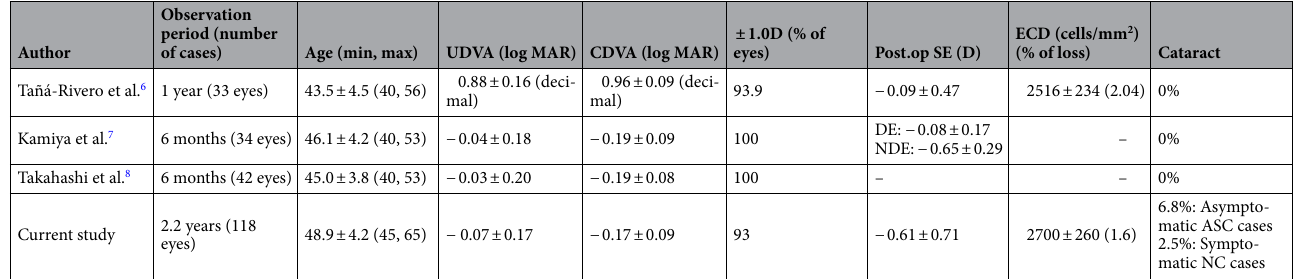
Table 5. The reports on Hole implantable collamer lens (ICL) implantation in patients over 40 years of age. UDVA uncorrected distance visual acuity, CDVA corrected distance visual acuity, SE spherical